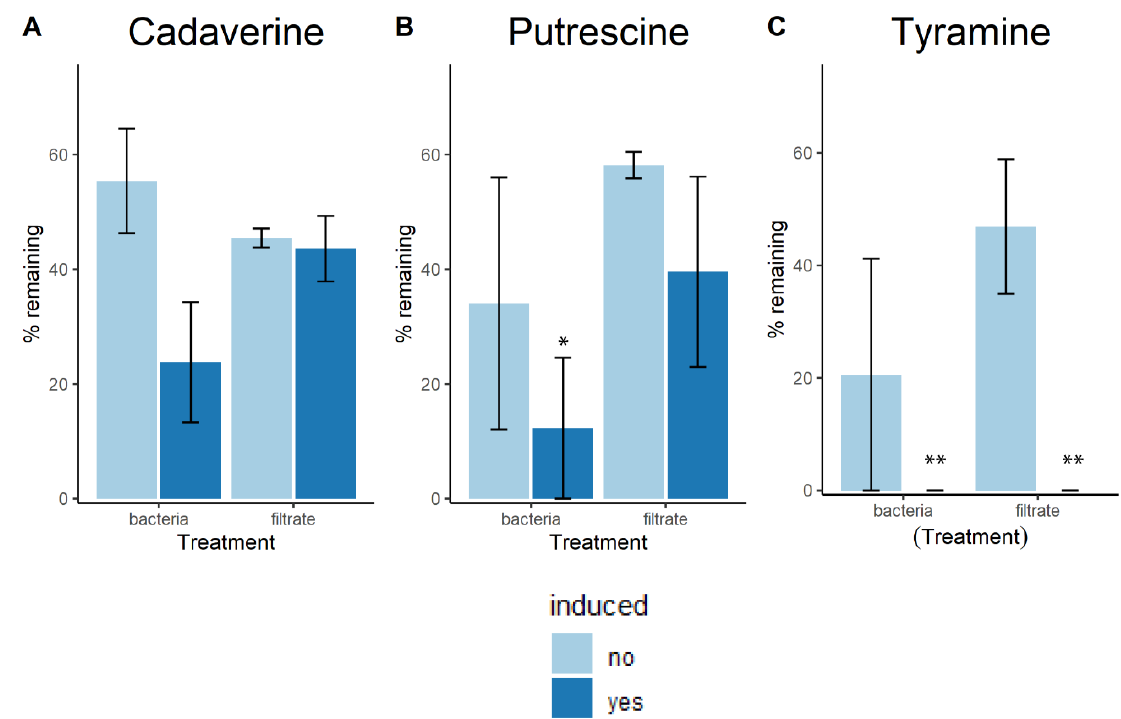
Figure 3. Biogenic amines exposure assay. Bar plots show the remaining concentration of ( A ) cadaverine, ( B ) putrescine, and ( C ) tyramine, after incubation with each amine of interest. One-way ANOVA with the Tukey post hoc test for multiple comparisons was used to calculate statistical significance (* p ≤ 0.05 and ** p ≤ 0.01). Data are presented as means of 3 independent experiments two technical replicates each ± 95% CI.